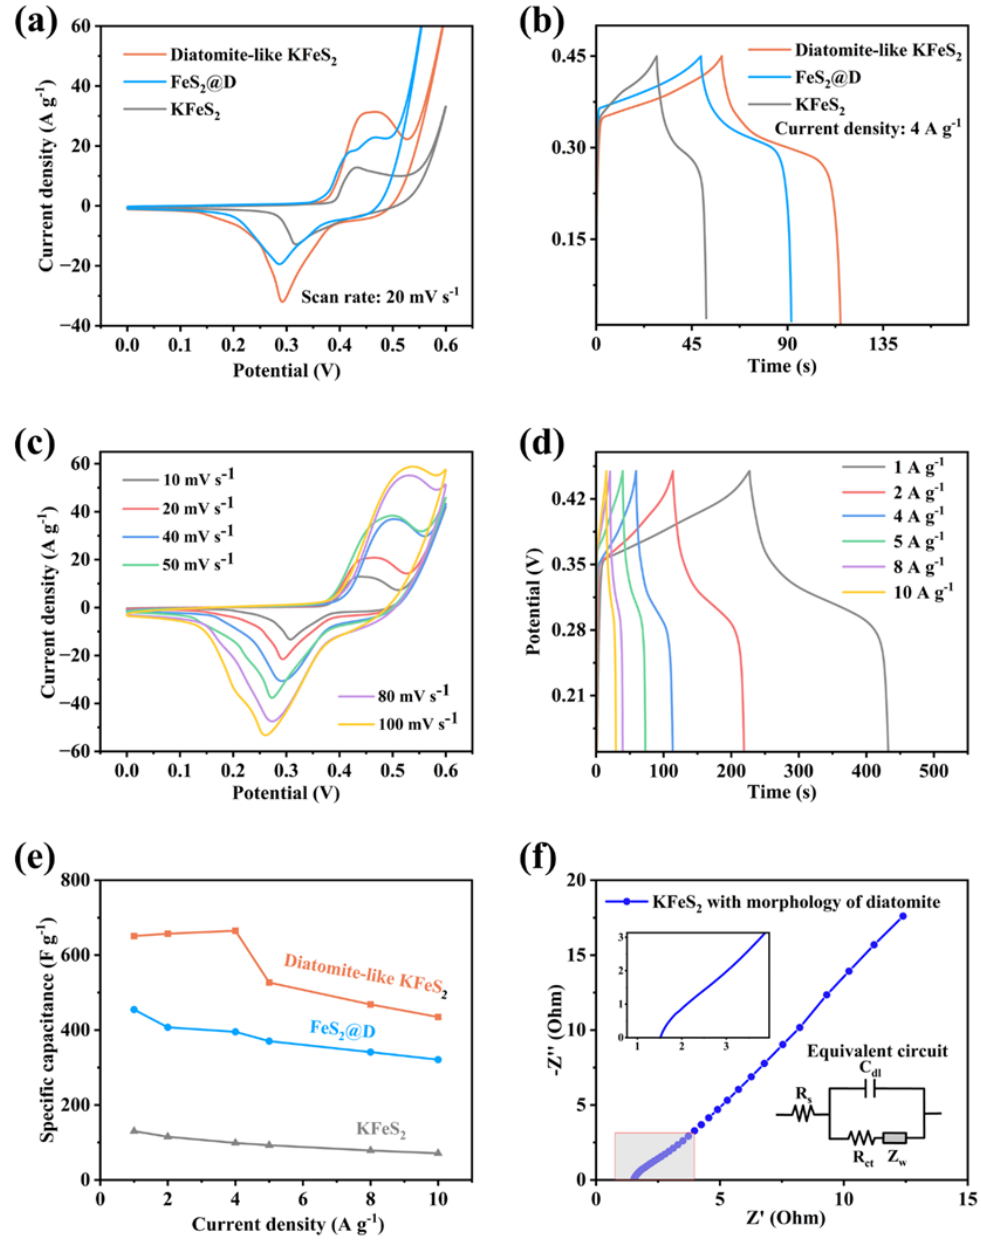
Figure 3. ( a ) The comparison of cyclic voltammograms at a scan rate of 20 mV s −1 between diatomite- like KFeS 2 , FeS 2 @D, and KFeS 2 ; ( b ) GCD curves of diatomite-like KFeS 2 , FeS 2 @D, and KFeS 2 at a current density of 4 A g −1 ; ( c ) cyclic voltammograms of diatomite-like KFeS 2 composite at different scan rate (10, 20, 40, 50, 80, and 100 mV s −1 ) in a 6 M KOH aqueous electrolyte; ( d ) GCD curves of diatomite-like KFeS 2 electrodes at different current densities (1, 2, 4, 5, 8, and 10 mA cm −2 ); ( e ) spe- cific capacitances of diatomite-like KFeS 2 , FeS 2 @D, and KFeS 2 measured under different current den- sities; ( f ) the electrochemical impedance spectrum of the diatomite-like KFeS 2 electrodes at open circuit potential in the frequency range from 0.01 Hz to 100 kHz (the inset is a partial enlargement of the curve).